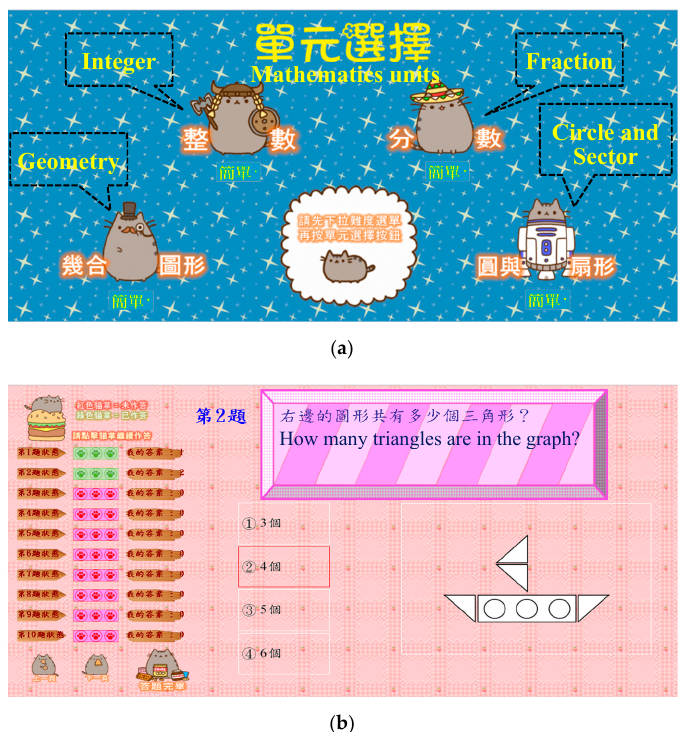
Figure 4. Part of the mathematics skills assessment system. ( a ) Four mathematics units in the system; ( b ) screenshot of test answers.